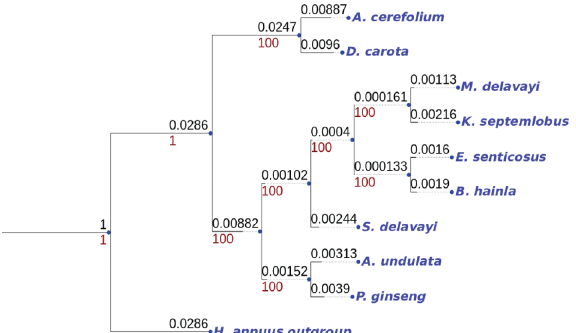
Figure 1: Most supported phylogenetic tree obtained from Apiales order. In this figure, the values at the top of the lines represent the branch lengths, while the values at the bottom correspond to the bootstrap supports (when it makes